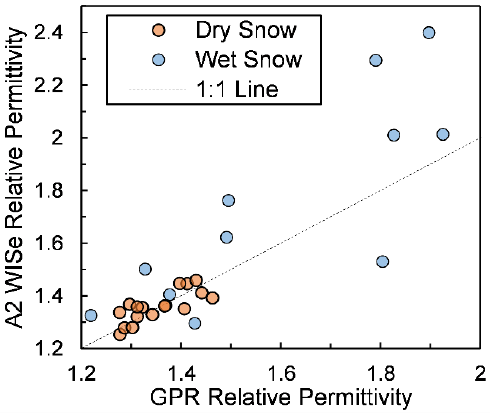
Figure A1. Comparison of relative permittivity estimates using a GPR and the A2 Photonics WISe sensor.